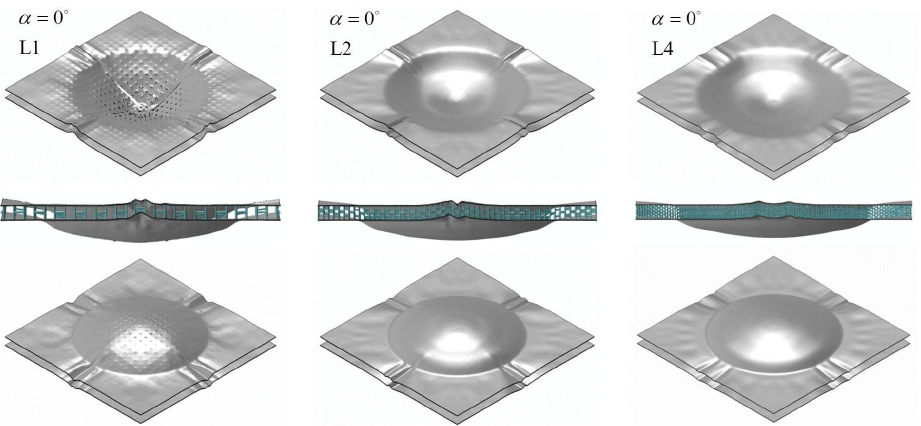
Figure A7. Deformation states of the top and bottom sides for 3D lattice, one- and multi-layered, non-auxetic cores with cell angle α = 0 ◦ subjected to air-blast loading (t = 0.6 ms).